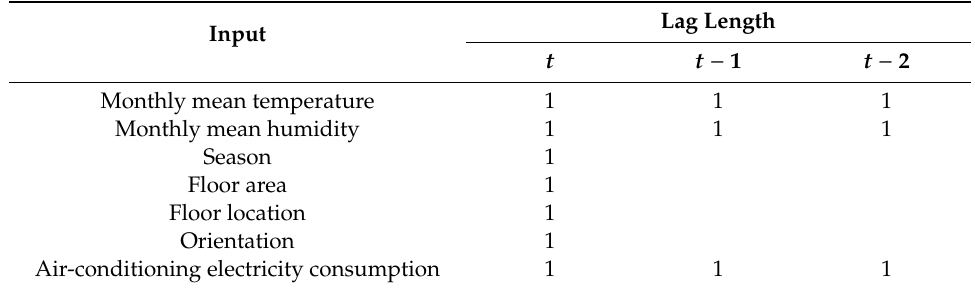
Table 5. The optimal input combinations of models determined by the grid research method. Lag Length Input t t − 1 t − 2 Monthly mean temperature 1 1 1 Monthly mean humidity 1 1 1 Season 1 Floor area 1 Floor location 1 Orientation 1